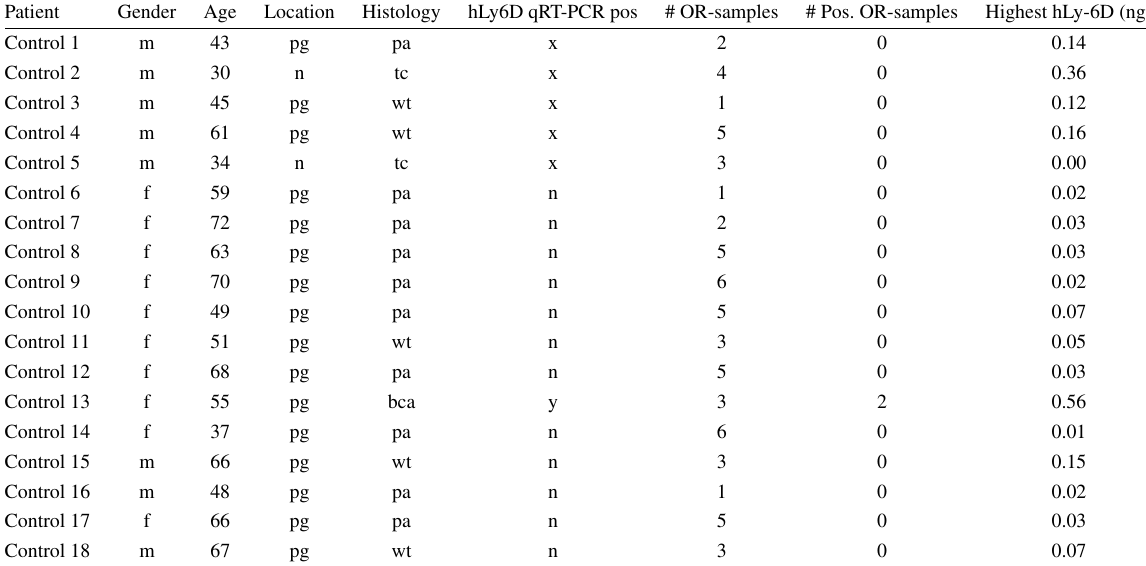
Characteristics of the non-cancer control patients and molecular